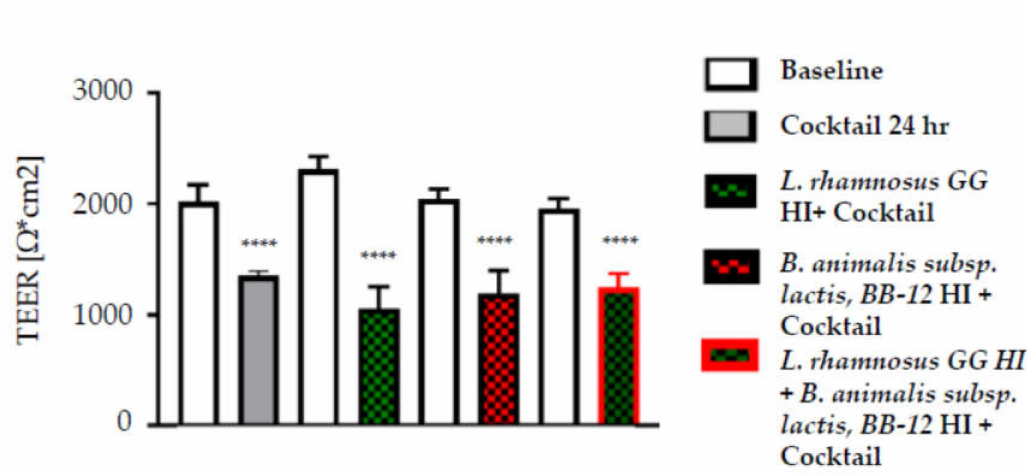
Figure 4. TEER measurements of Caco-2 cell cultures exposed to a cocktail of inflammatory cytokines following 24 h pretreatment with heat-inactivated (HI) L. rhamnosus GG or B. animalis subsp. lactis , BB-12 or their combination. L. rhamnosus GG was heat-inactivated for 3 min at 70 ◦ C while or B. animalis subsp. lactis, BB-12 was heat-inactivated for 6 min at 62.3 ◦ C. Data are mean + SEM ( n = 9). **** p < 0.0001 vs. baseline.